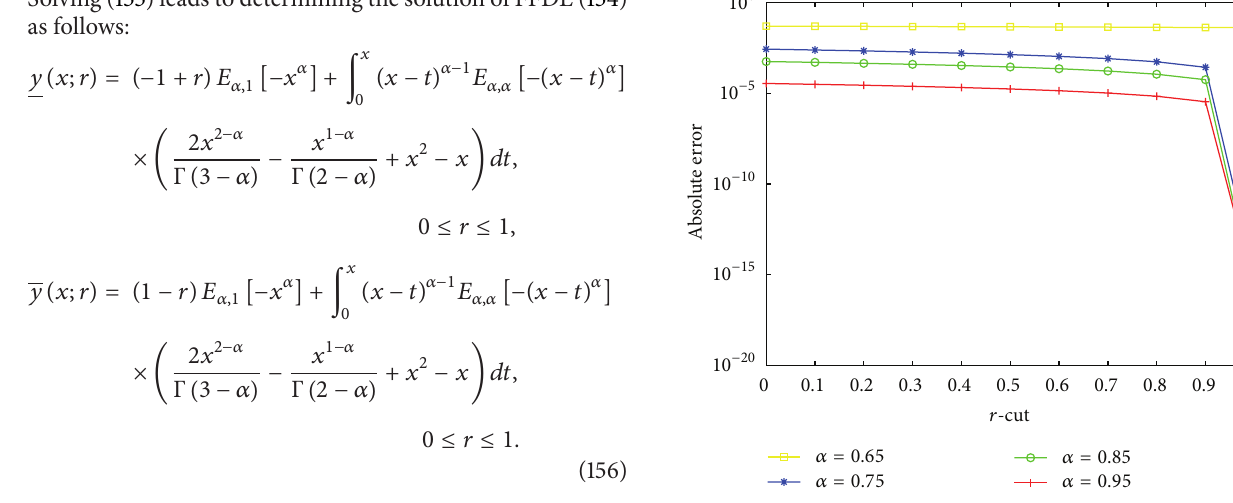
Figure 10: The absolute error for different 𝛼 of Example 60, 𝑚 = 5